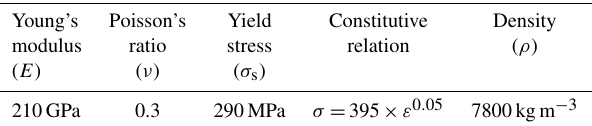
Table 1. Material